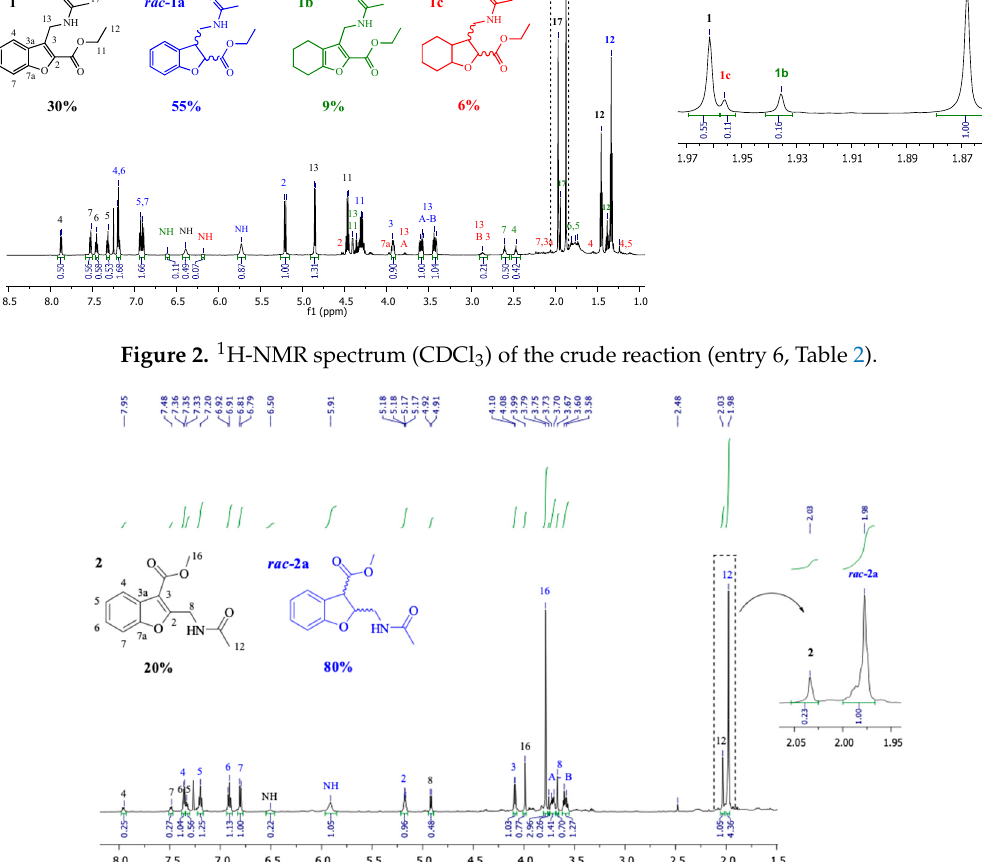
Figure 3. 1 H-NMR spectrum (CDCl 3 ) of the crude reaction (entry 12, Table 2).